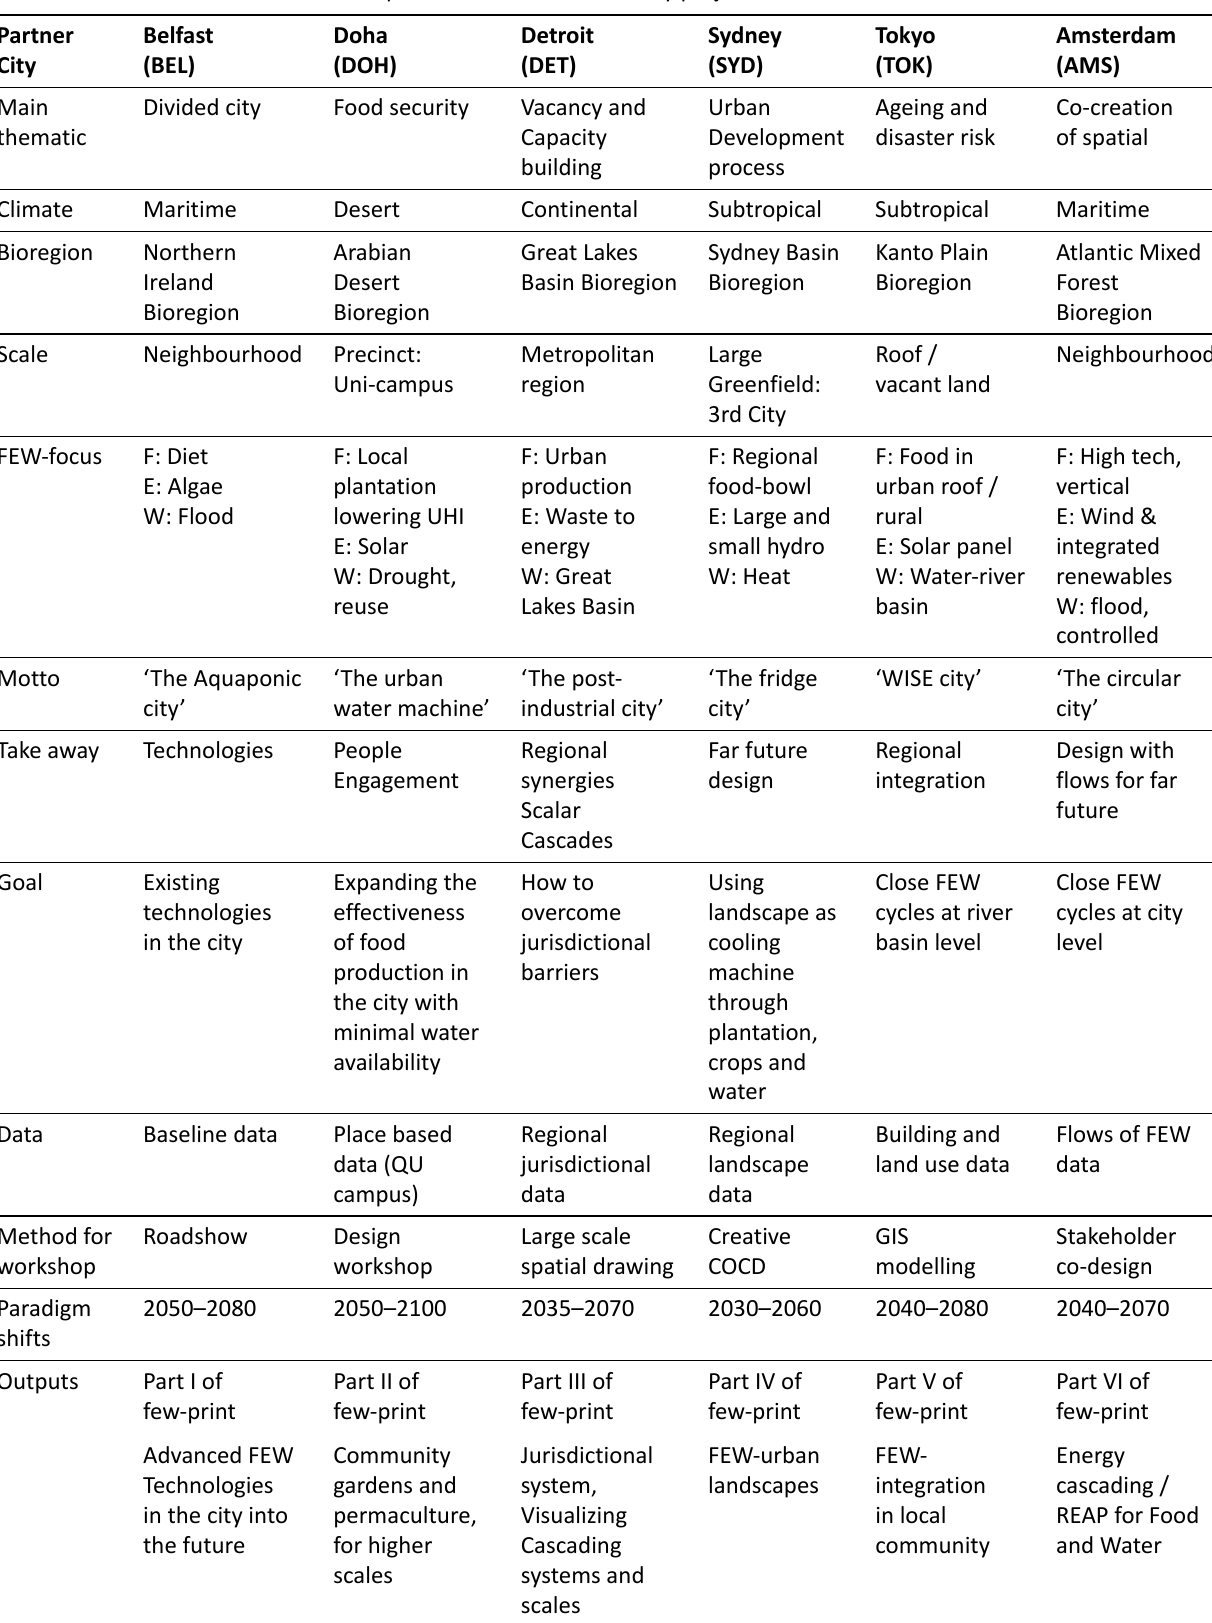
Table 1. Overview of characteristics of partner cities and case study projects.